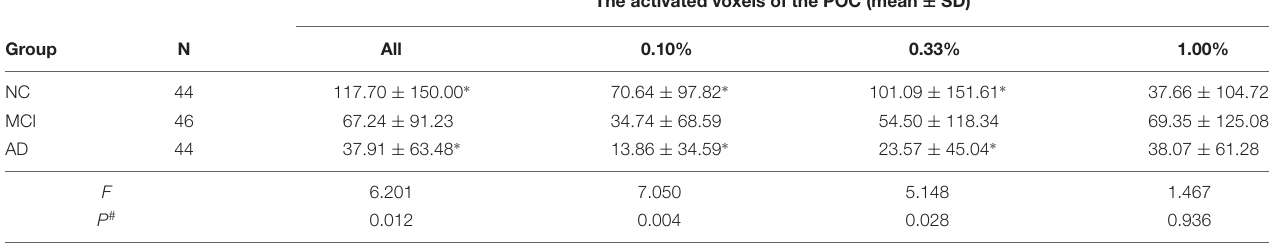
(cid:49) Represents the χ 2 value. The MCI, AD, and NC did not different with respect to age, gender, and education years. ∗ Represents significantly difference between AD and NC groups of MoCA and MMSE; # Represents significantly difference between MCI and NC groups of MoCA and MMSE; ∧ Represents significantly difference between MCI and AD groups of MoCA and MMSE. TABLE 2 | The activated voxel numbers in the POC of the three groups. The activated voxels of the POC (mean ±